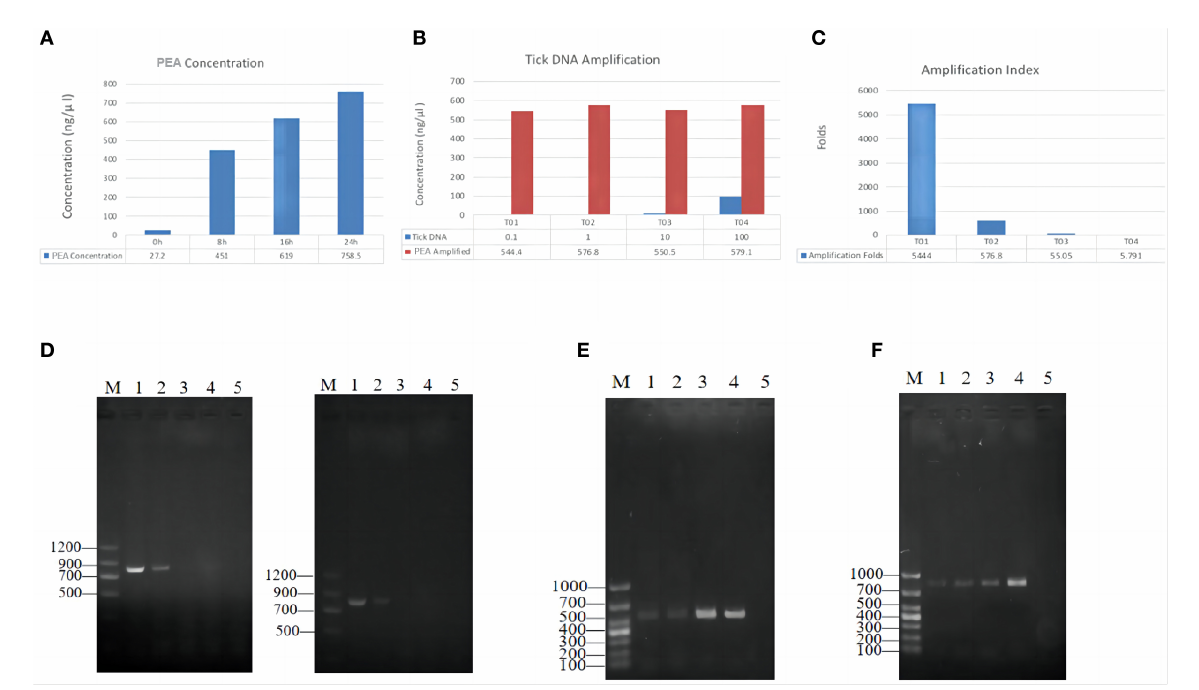
FIGURE2 PEA amplification efficacy of single tick DNA. (A) Effects of incubation time on final PEA product concentration; Tick DNA was amplified for 8, 16 and 24h, the product concentration was positively correlated with the incubation time. (B) Amplification index for different amount of starting DNA. (C) DNA increase folds after PEA. (D) Amplification of ompB , gene from original tick DNA with different template concentrations, original DNA (Left), PAE Amplified DNA (Right); M, marker, 1–4, represent diluted PEA product concentration of 100, 10, 1, and 0.1 ng/ µ l, 5, negative control. (E) Amplification of ompA gene from PEA products. M, marker, 1–2 represent original DNA, 3–4 represent PAE Amplified DNA, the concentration was 10, 100, 10, and 100 ng/ µ l, respectively, and 5 was negative control. (F) Amplification of gltA gene from PEA products. Gel lane were same as (E)